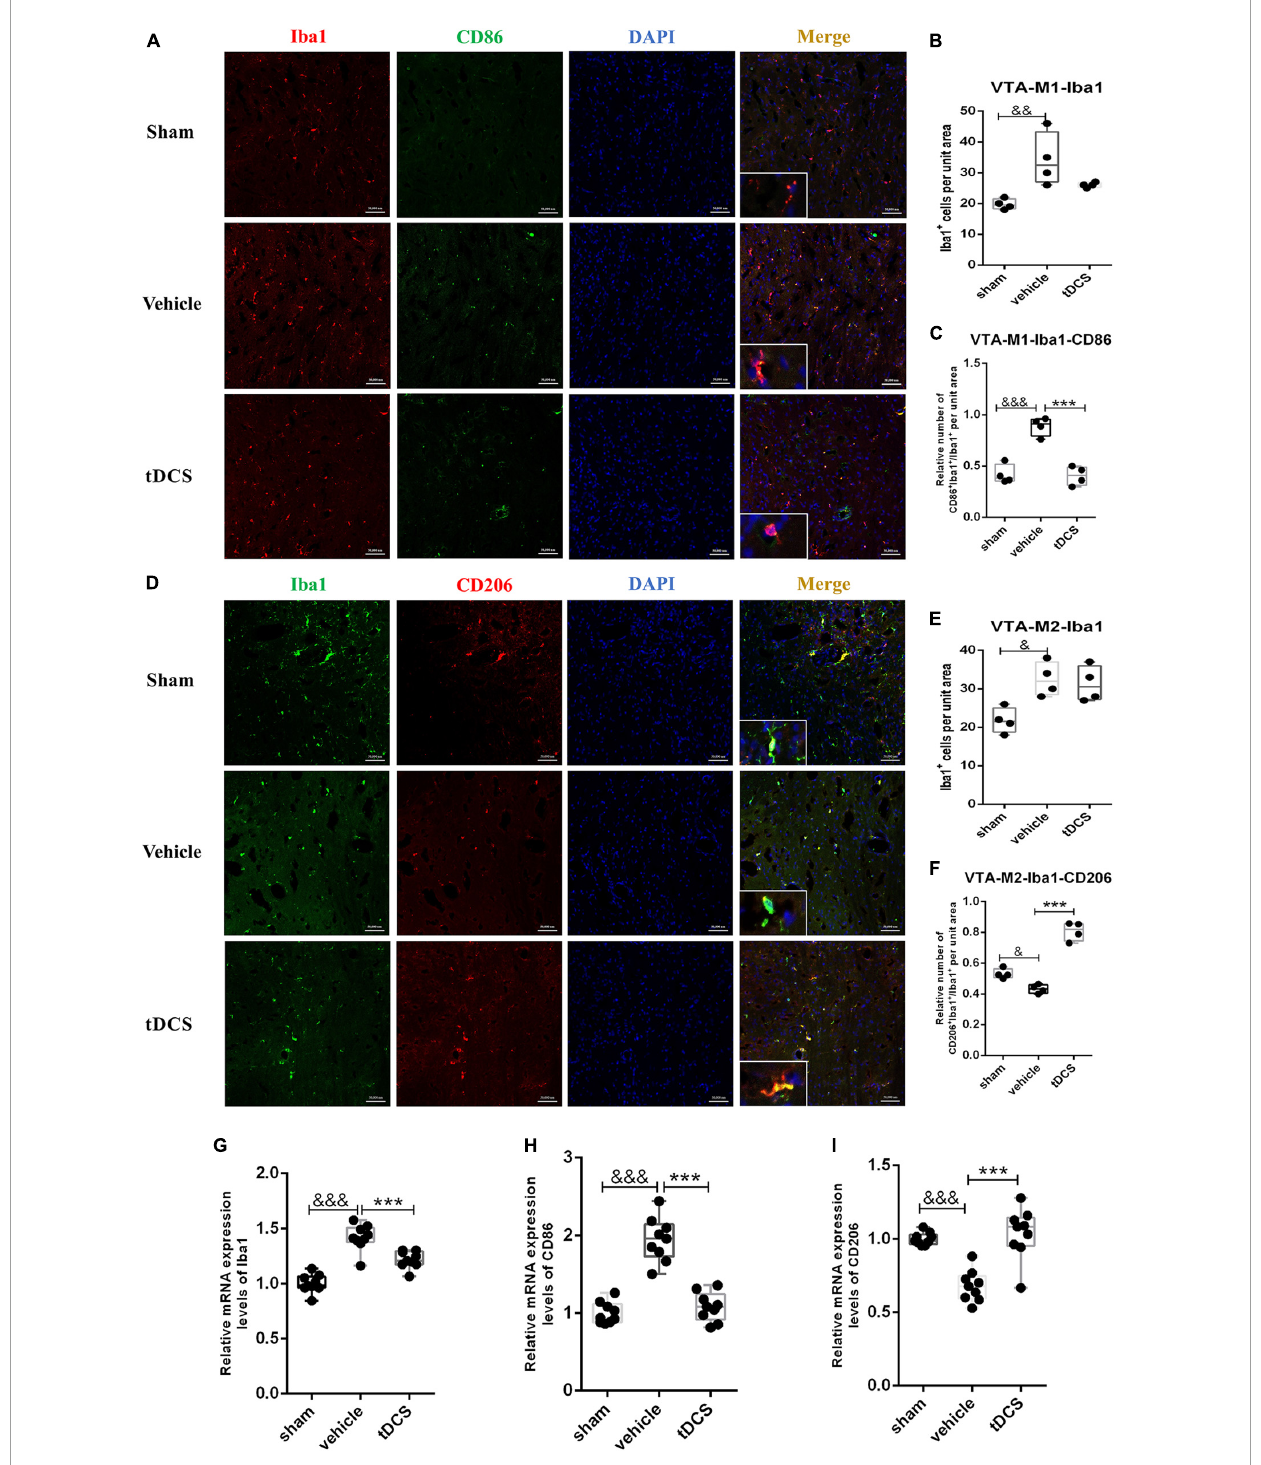
FIGURE6 tDCS alters microglial polarization direction in the midbrain VTA region. (A) Iba1 and CD86 protein immunofluorescence co-staining in three groups. Iba1 protein was stained with red fluorescence, and CD86 protein was stained with green fluorescence. Nuclei were labeled with blue fluorescence. Merged pictures show positive cells. Bar = 50 µ m. (B) Statistical analysis results of the expression of Iba1 in microglia of each group. (C) Statistical analysis results of the proportion of CD86 and Iba1 positive cells to Iba1 positive cells in microglia of each group. (D) Iba1 and CD206 protein immunofluorescence co-staining in three groups. Iba1 protein was stained with green fluorescence, and CD206 protein was stained with red fluorescence. Nuclei were labeled with blue fluorescence. Merged pictures show positive cells. Bar = 50 µ m. (E) Statistical analysis results of the expression of Iba1 in microglia of each group. (F) Statistical analysis results of the proportion of CD206 and Iba1 positive cells to Iba1 positive cells in microglia of each group. (G–I) Relative mRNA expression levels of Iba1, CD86 and CD206 in each groups, as detected by qRT-PCR. Vehicle group vs. sham group, &&& p < 0.001, && p < 0.01 and & p < 0.05; tDCS group vs. vehicle group, *** p < 0.001, n =